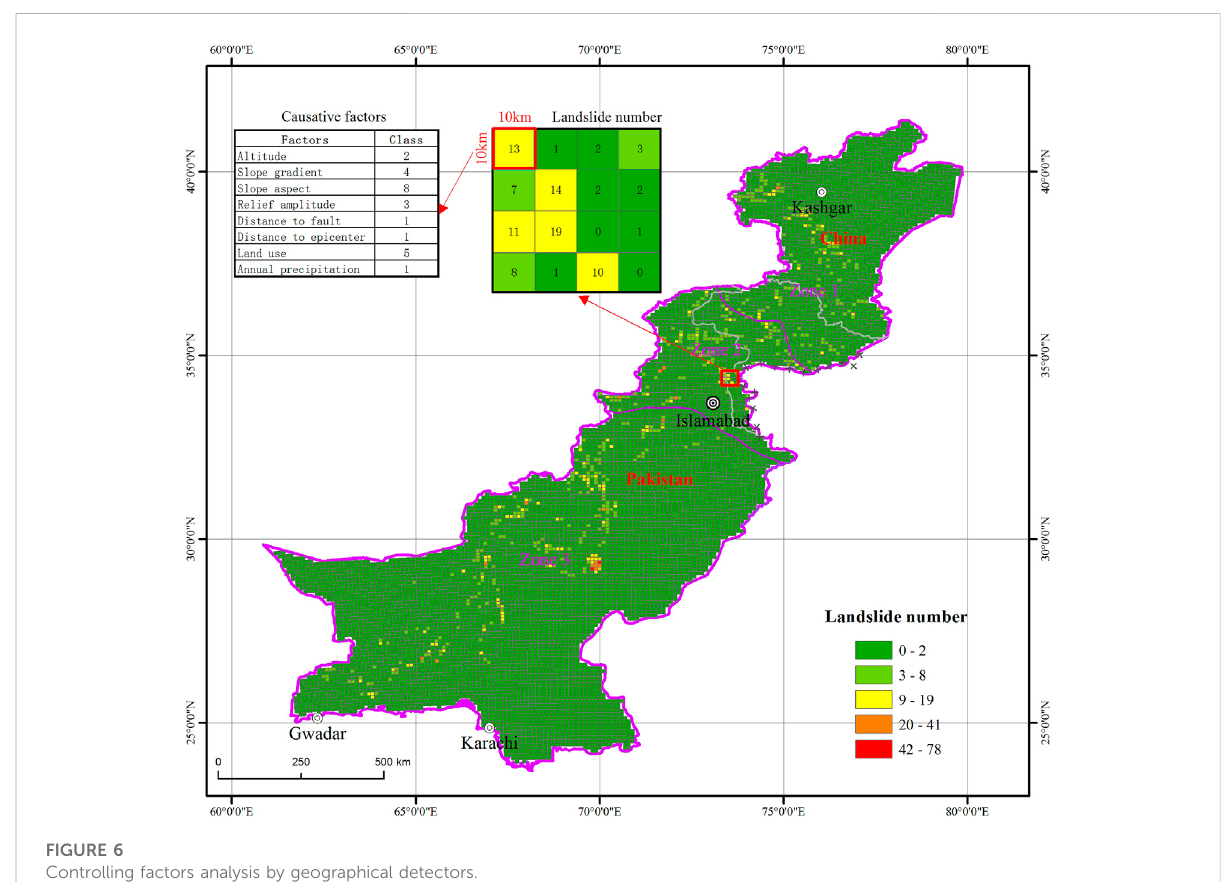
FIGURE 6 Controlling factors analysis by geographical detectors.